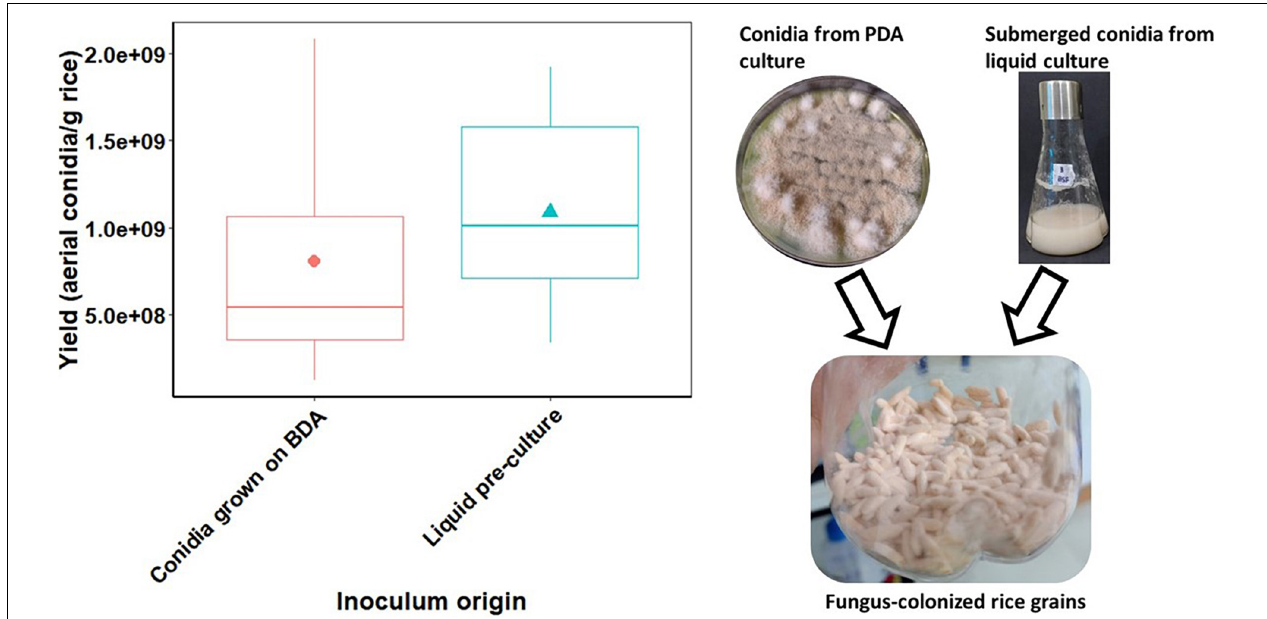
FIGURE 1 | Impact of inoculum type (PDA-grown aerial conidia and conidia-grown in liquid culture) on the yield of aerial conidia of Clonostachys rosea (strain CMAA1284) after 7 days of cultivation on sterile parboiled rice grains.